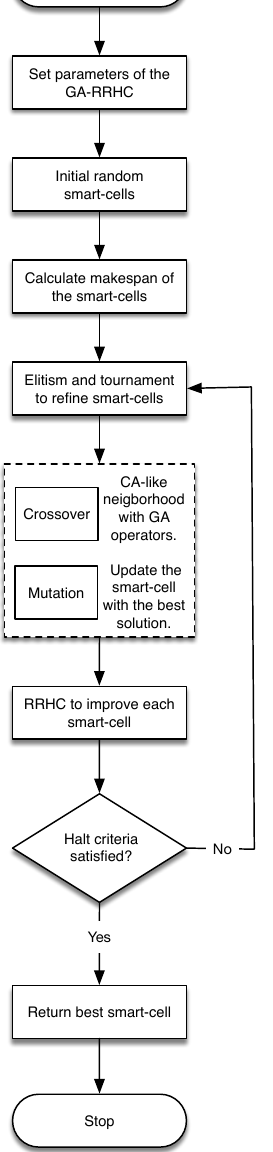
Figure 12. GA-RRHC